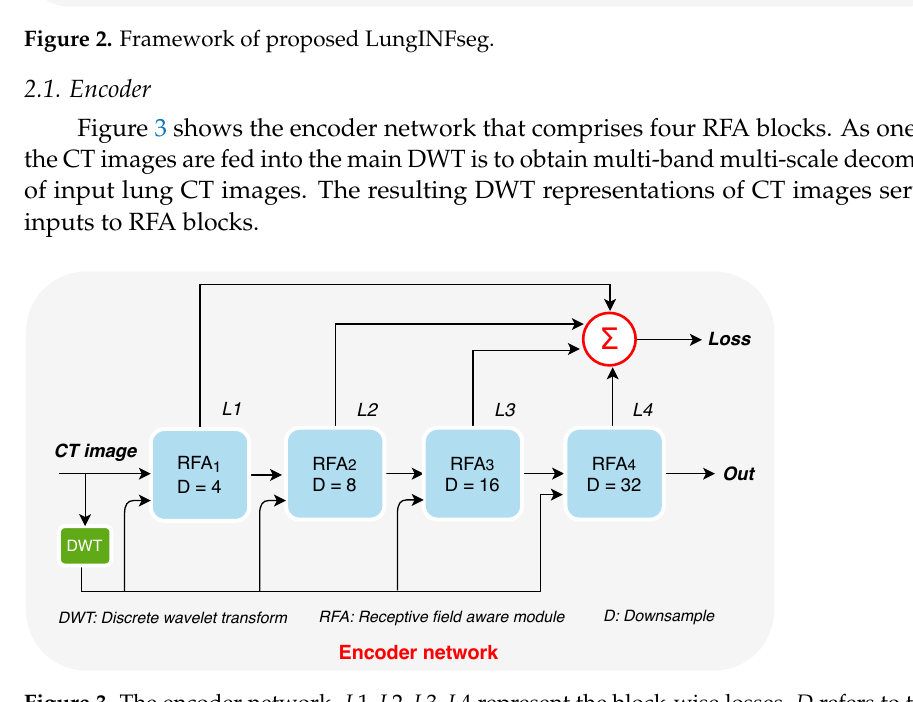
Figure 3. The encoder network. L 1, L 2, L 3, L 4 represent the block-wise losses. D refers to the down- sampling rate. Out represents the output features generated by the Encoder network. RFA refers to the receptive field aware module. DWT refers to the discrete wavelet